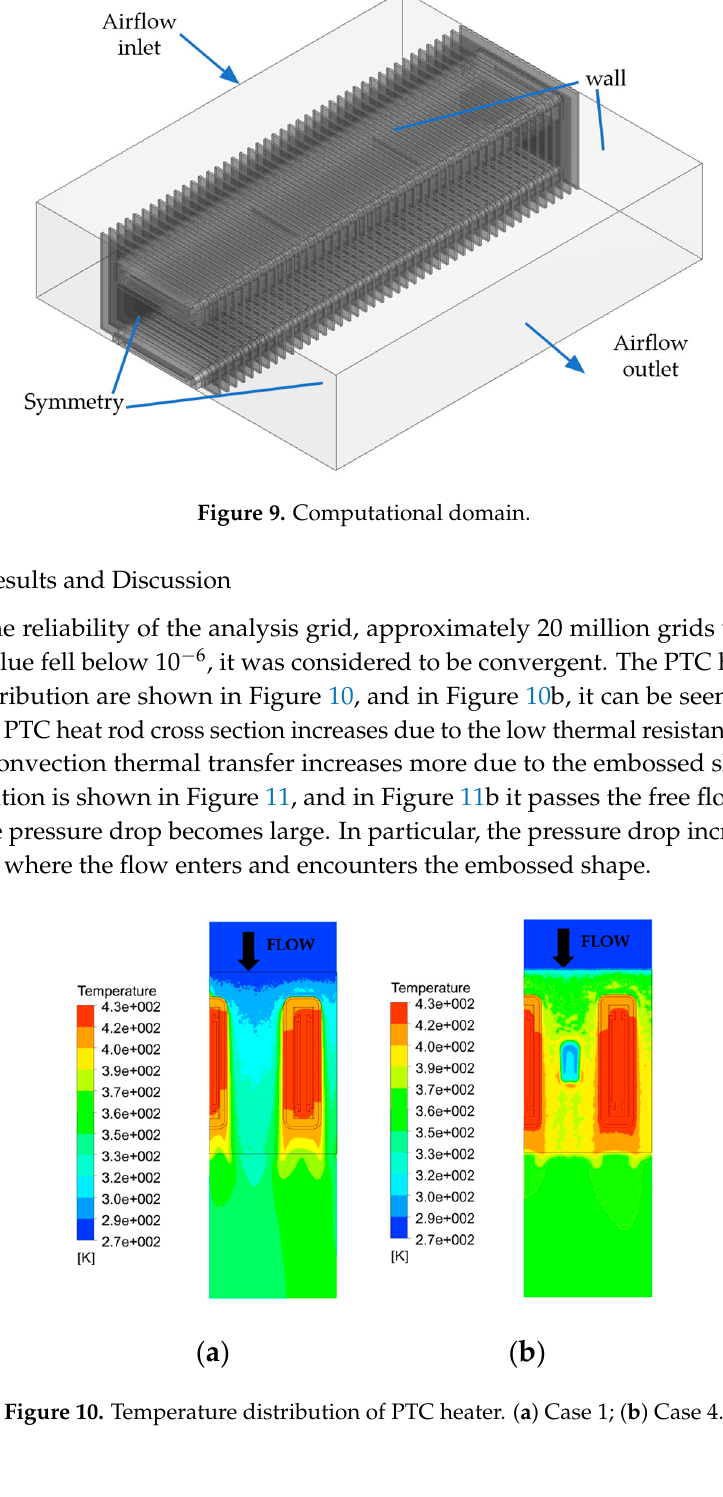
( b ) Figure 11. Pressure drop of PTC heater. ( a ) Case 1; ( b ) Case 4. Table 6. Analysis results of high voltage PTC Heater. Description